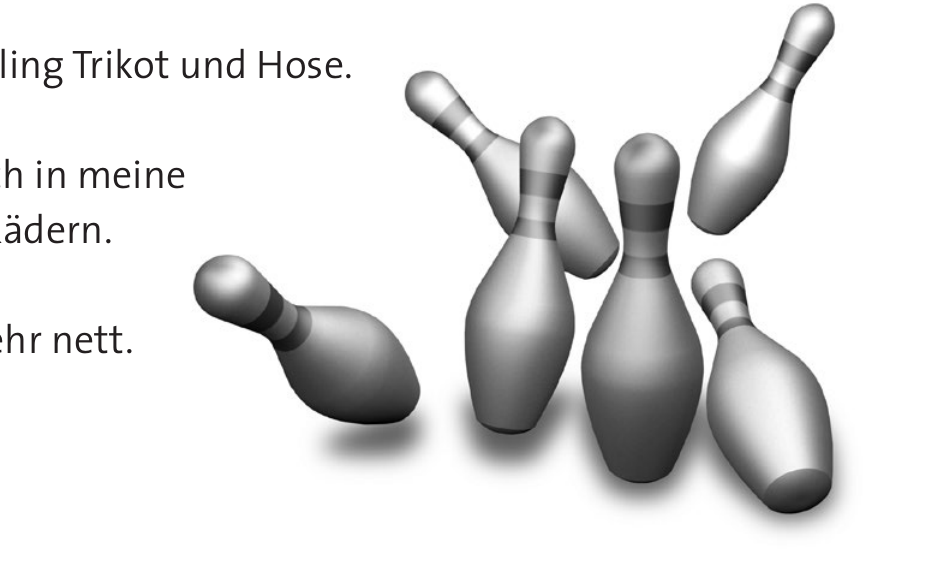
Das ist 1 Bowling Ball, 1Tuch für die Hände. Bowlingschuhe, Bowling Trikot und Hose. Meine Sachen lege ich in meine Bowling Tasche auf Rädern. Meine Trainer sind sehr